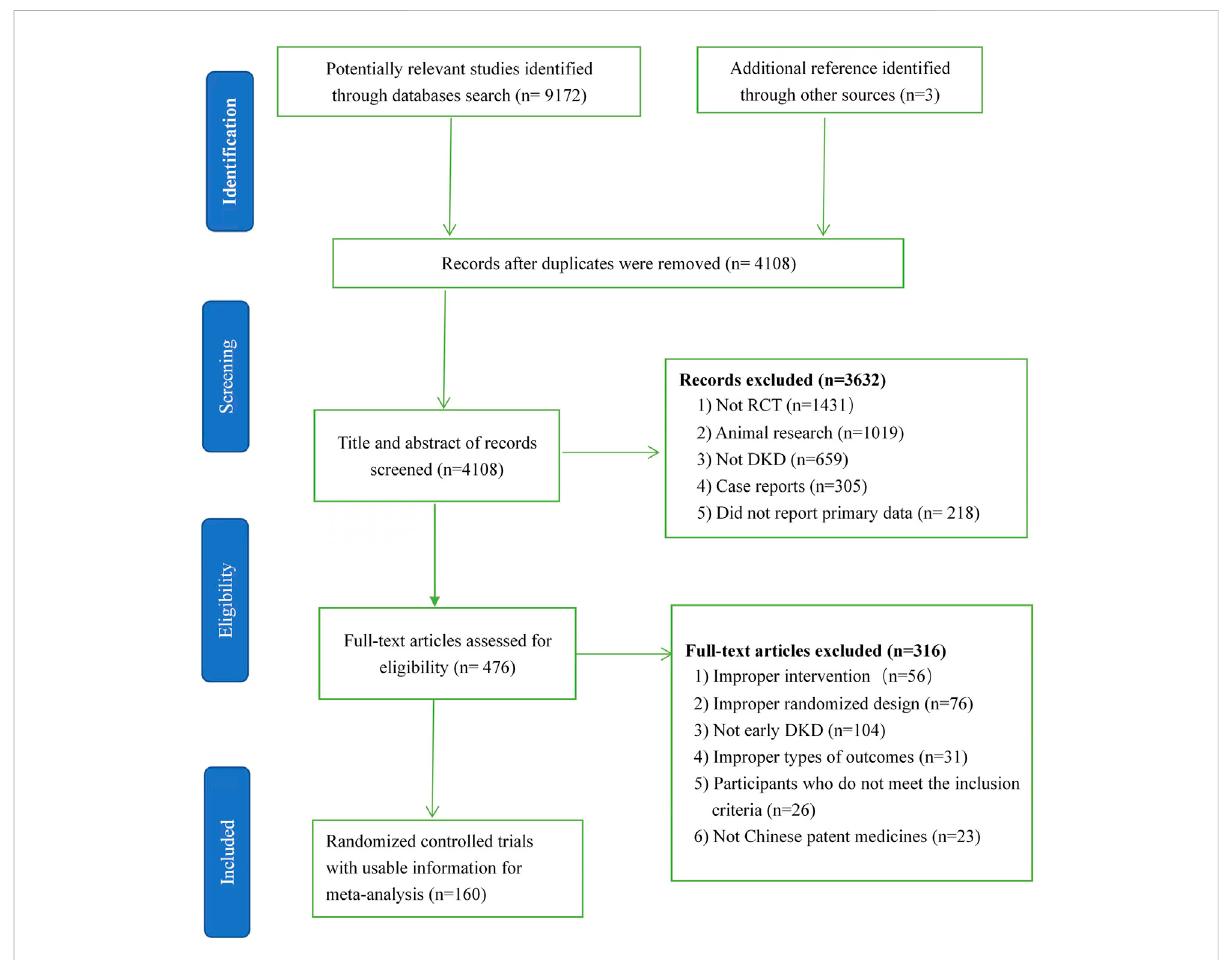
FIGURE 1 Flow chart of search and selection. DKD, diabetic kidney disease; RCT, randomized clinical trial.